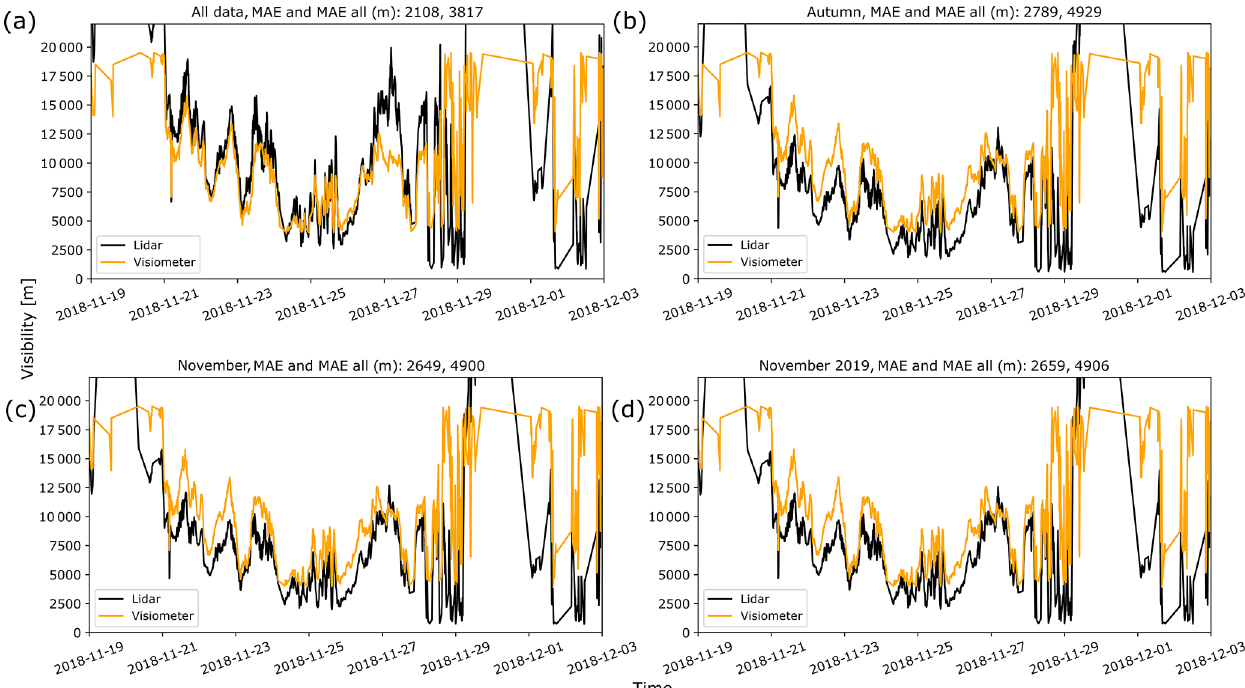
Figure 11. Lidar-derived visibility time series and readings from visiometers for Cabauw. Also shown is the mean absolute error (MAE) between the two time series. MAE is for the plotted period only, and MAE all is for the whole data period of 24 months. (a) Fit used all data. (b) Fit used autumn data only. (c) Fit used data from Novembers only. (d) Fit used data from November 2019 only. Lidar-derived visibilities outside the [4, 20]km range used for retrieval have been excluded from the calculation of MAE but are plotted to illustrate the effect of extrapolating the transfer function outside that